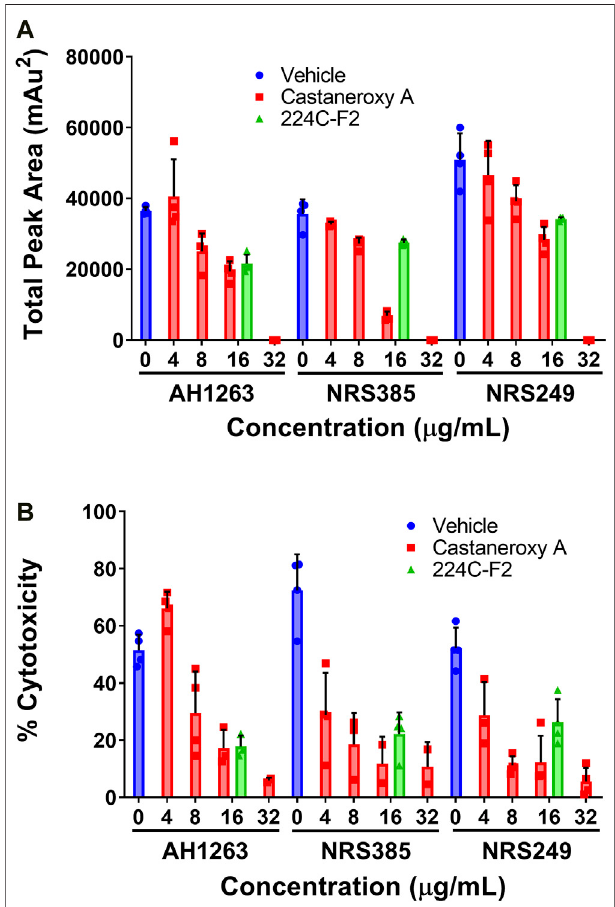
FIGURE 8 | Castaneroxy A ( 1 ) inhibits δ -toxin production in a concentration-dependent manner. The strains AH1263 (LAC), NRS385, and NRS249, were cultured in the presence of increasing concentrations of 1 . (A) Supernatants from 15-hour cultures were analyzed by HPLC for the detection of δ -toxin. (B) HaCaT human keratinocytes were incubated in the presence of fi ltered culture supernatants (the same supernatants from part A) for 24 h; cytotoxicity was subsequently assessed by LDH assay. In both graphs, the dark-colored symbols represent the response of each replicate of a treatment-concentration. Each treatment-concentration was performed in quadruplicate;eachexperimentwasperformedinduplicateonseparatedays. Shown are the results of one of the duplicates of each experiment. Error bars represent